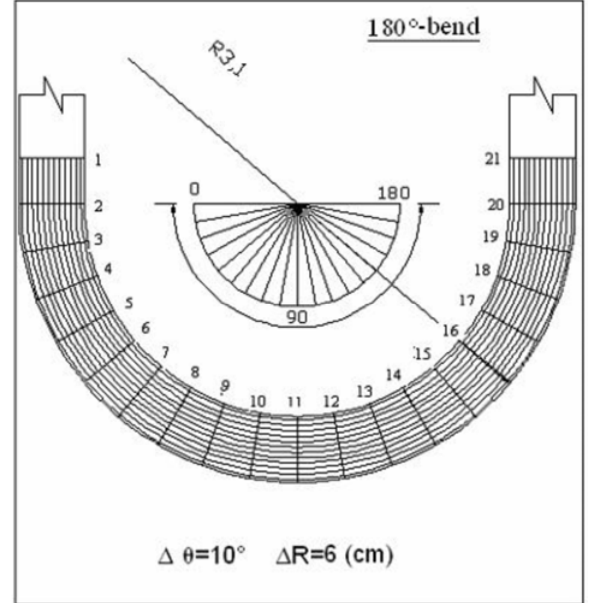
Fig. 6. Channel geometry and measured section of 1800 -